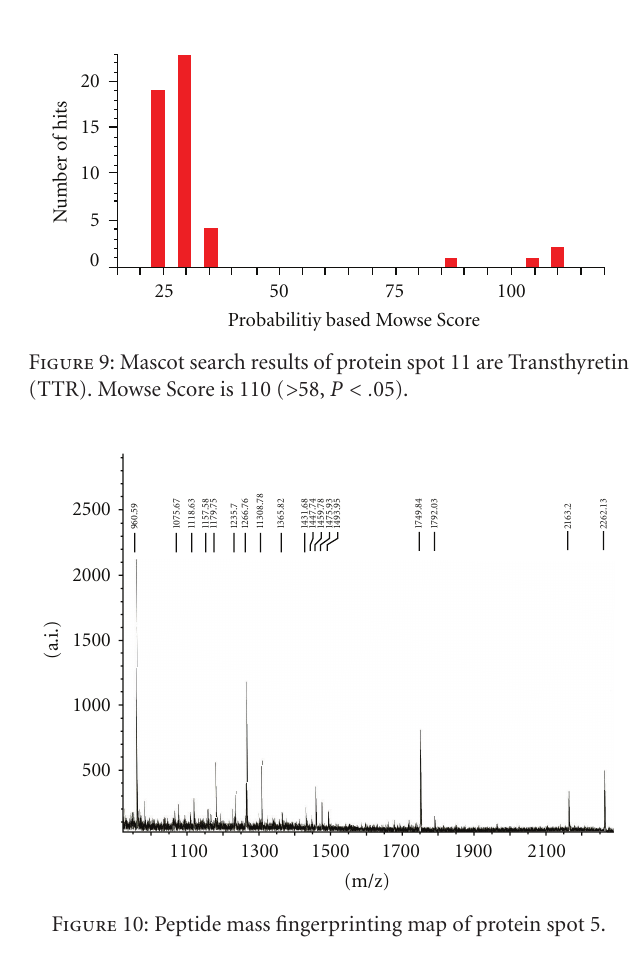
AOE372, ATP5D, B4GALT, cytosolic inorganic pyrophos- phatase (PPase), GRP58, GSTM4, P4HB, TPI, and